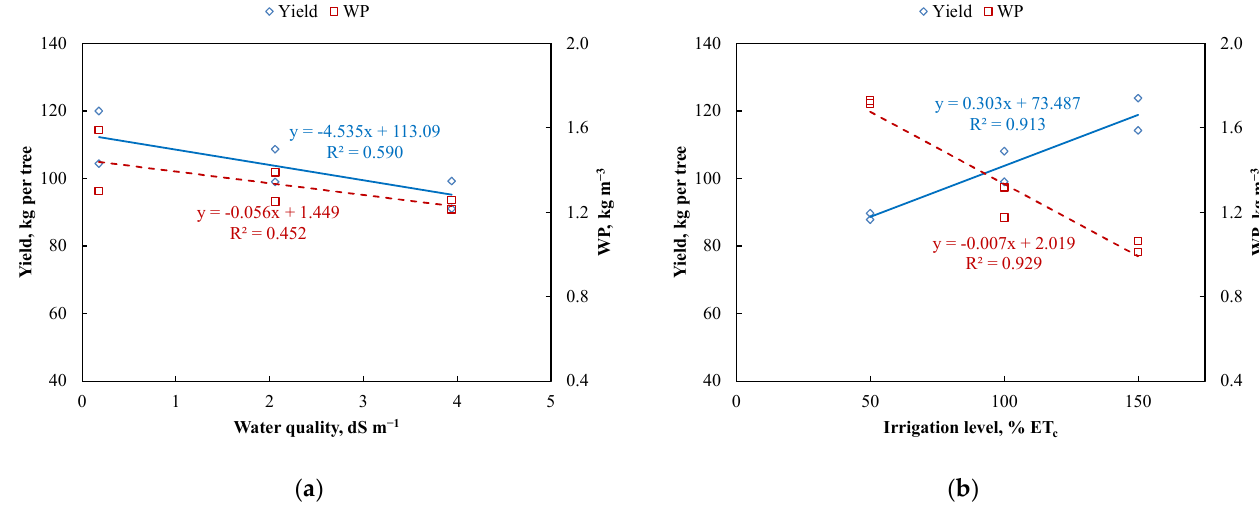
Figure 6. Relationships of ( a ) water quality and ( b ) irrigation levels with either yield or water productivity (WP) of date palms from the pooled data obtained during the experimental years. Table 5. Comparison of physical characteristics of dates across the experimental treatments from 2017 to 2018. Treatment